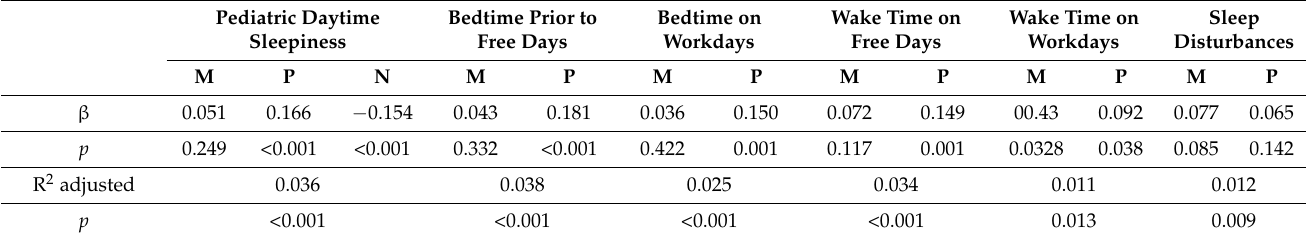
Table 2. Regression analysis of DT traits on sleep-related